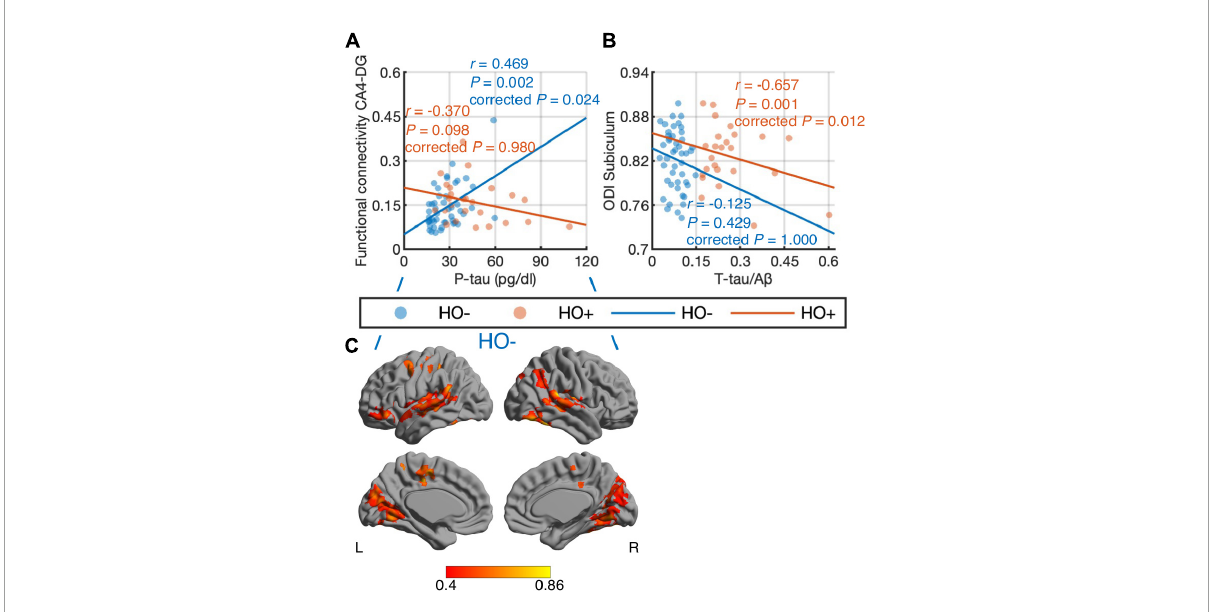
FIGURE6 Correlations of CSF biomarker measurements with hippocampal subfield connectivity and diffusion metrics: tau phosphorylated at threonine 181 (P-tau) vs. functional connectivity in CA4-DG network (A,C) and total tau (T-tau)/amyloid- β 1-42 (A β ) ratio vs. orientation dispersion index (ODI) in the subiculum (B) . The associations were evaluated using partial correlation with age, sex, normalized whole hippocampal volume, and total intracranial volume as covariates. P -values were adjusted for multiple comparisons using Holm-Bonferroni correction. Blue and orange dots represent healthy older adults with negative CSF biomarker status (HO − ) and positive CSF biomarker status (Ho+), respectively. The fitting lines are also shown to indicate trends for HO − (blue lines) and Ho+ (orange lines). In voxel-wise analysis in HO − (C) , the results were corrected using threshold-free cluster enhancement where family-wise error rate was controlled at